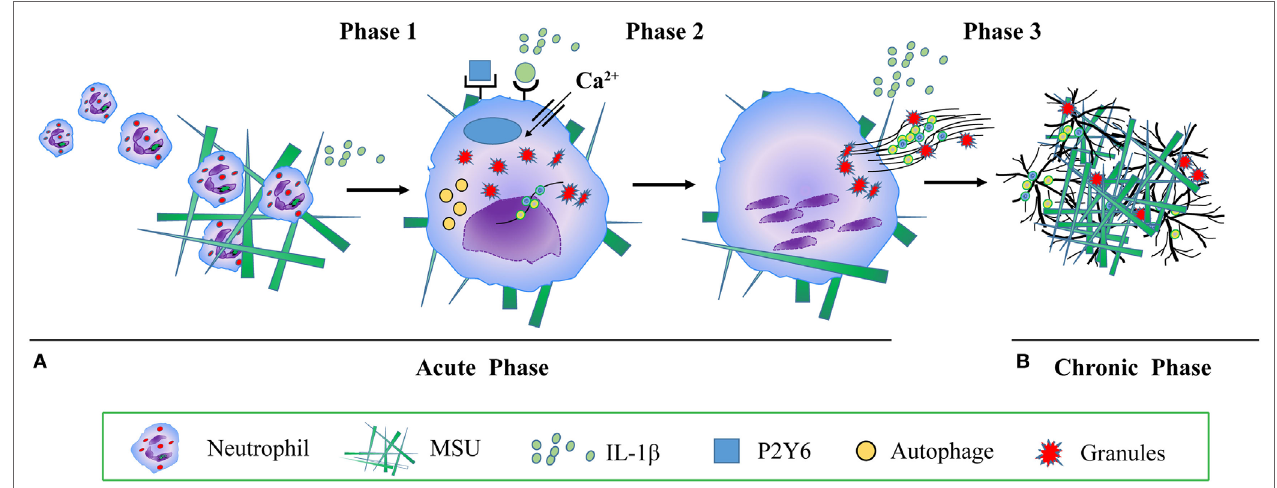
FigURe 1 | The molecular mechanism of monosodium urate (MSU) crystals induced neutrophil extracellular traps (NETs) and aggregated NETs (aggNETs) formation. (A) Acute gouty attack: phase 1 MSU crystals induce mononuclear phagocytes to secrete cytokines and chemokines, including interleukin (IL)-1 β , tumor necrosis factor, IL-6, and IL-8. IL-1 β recruits further neutrophils into the synovial joint; phase 2 neutrophils take up MSU crystals, a process activating reactive oxygen species, autophagy, RIPK1-RIPK3-MLKL signaling, P2Y6 receptor, endosomal acidification, calcium entry channel, IL-1 β , and inducing NETs formation. NETs release dangerous neutrophils’ cargo, such as histones, MPO, NE, cytokine, DAMPs, chemokines, leading to acute, painful, and tissue-damaging inflammation; (B) chronic tophaceous gout: phase 3 under conditions of high neutrophil densities, aggNETs are formed, degrade pro-inflammatory chemokines and cytokines, and suppress crystal-induced inflammation. Abbreviations: MPO, myeloperoxidase; NE, neutrophil elastase; DAMPs, danger associated molecular